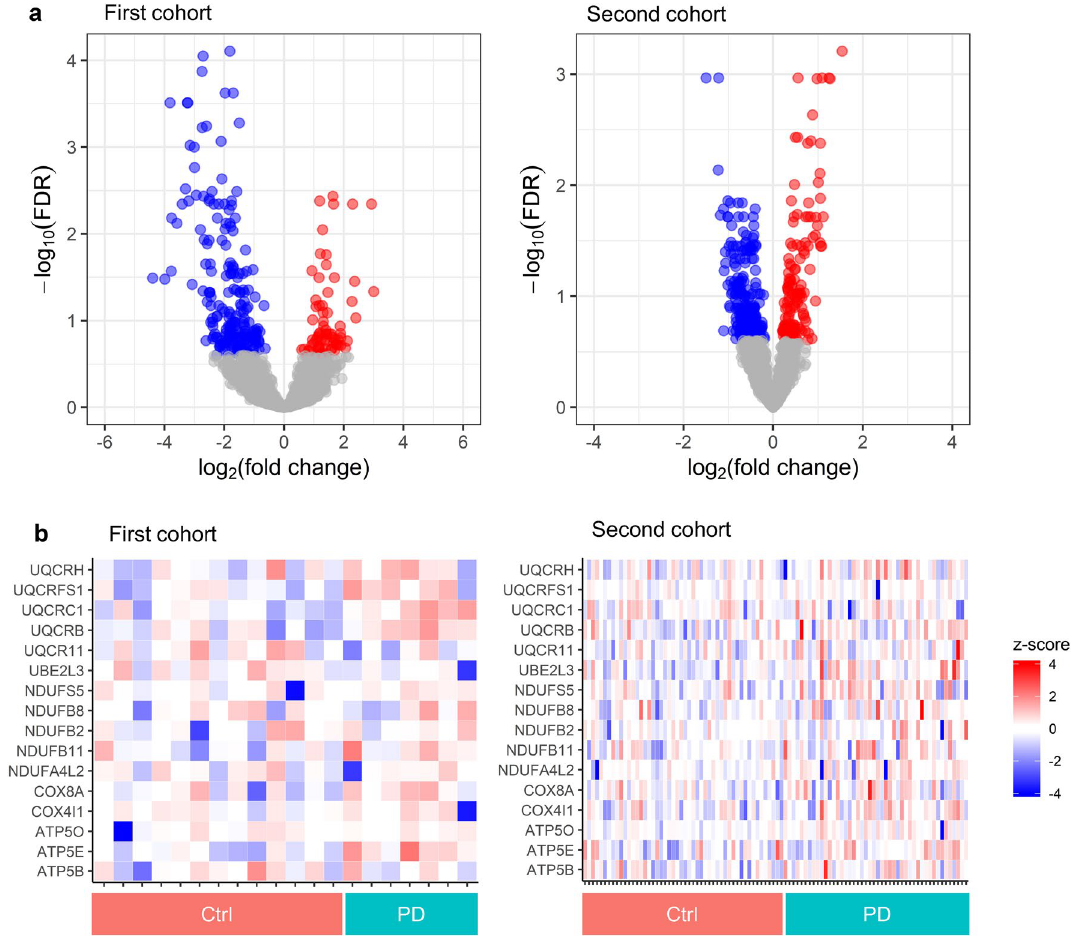
Figure 2. Differential expression analysis using SSL-RNAs in PD. ( a ) Volcano plot of expression changes in PD. In the first cohort, 209 genes were downregulated (blue) and 74 genes were upregulated (red). In the second cohort, 308 genes were downregulated (blue) and 151 genes were upregulated (red). Genes with FDR < 0.25 were considered to have a significant change. ( b ) Heatmaps of oxidative phosphorylation-related genes. Expression levels were converted to z -scores by genes. The gray color indicates missing values. Ctrl healthy controls, FDR false discovery rate, NA not available, PD Parkinson’s disease. The plots were constructed using ggplot2 and gplots R package 19,24